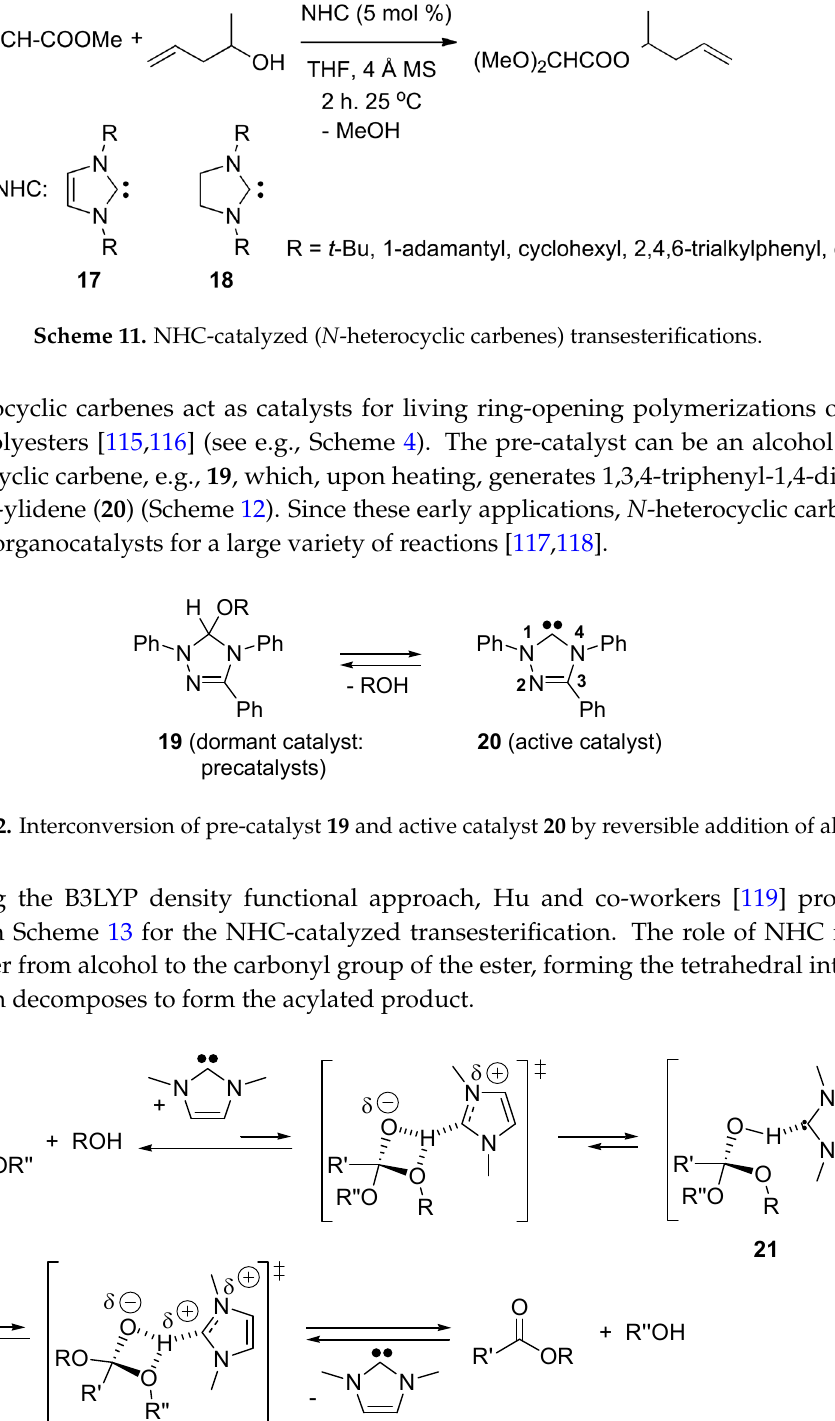
Scheme 13. One possible mechanism of the N ‐ heterocyclic carbenes (NHC) ‐ catalyzed transesterification.